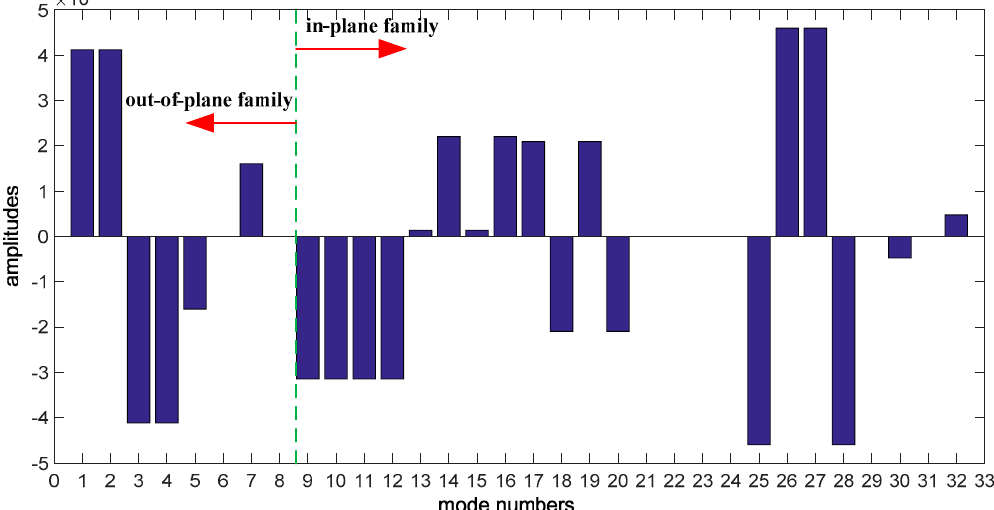
Figure 5. Deformed cross-sections of the free end for the first four modal shapes of the thin-walled structure with a rectangular hollow cross-section: ( a ) The 1st modal, ( b ) the 2rd modal, ( c ) the 3rd modal, and ( d ) the 4th modal.